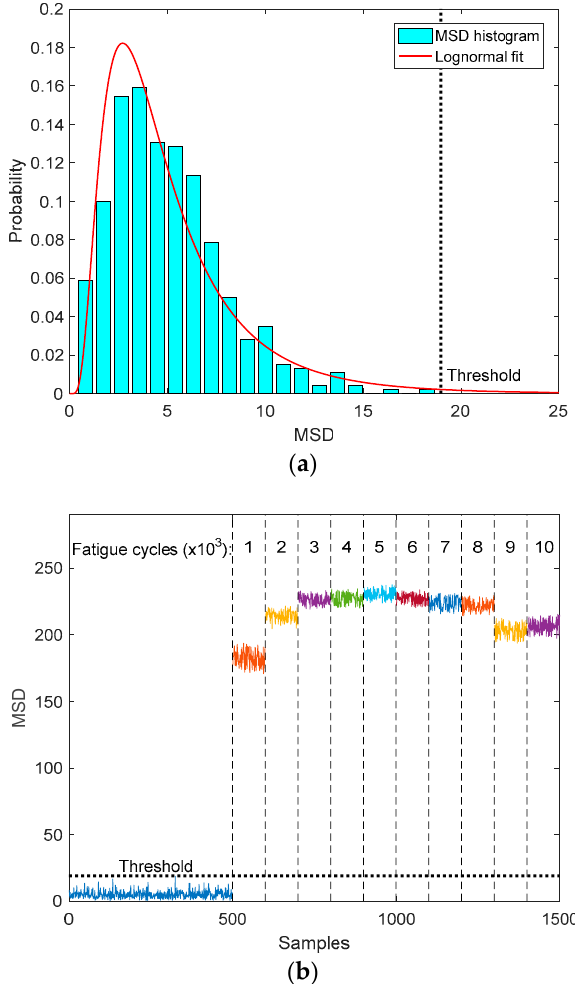
Figure 11. Outlier analysis results for specimen S_B with Level 1 contamination: ( a ) PDF of baseline MSD and ( b ) MSDs for different fatigue states.